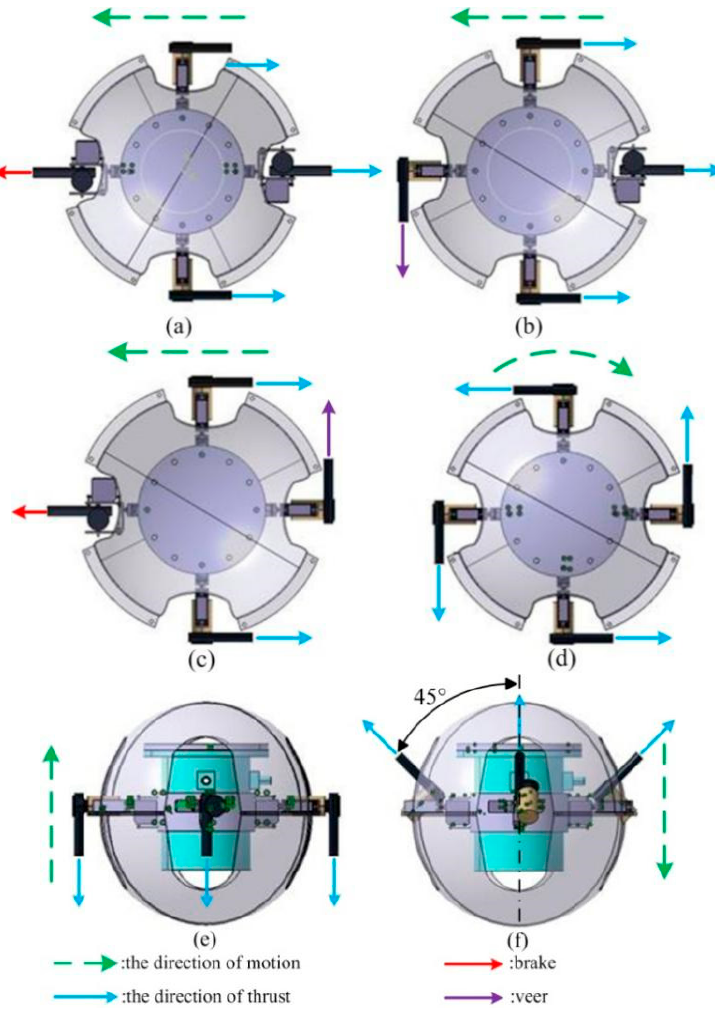
Figure 11. Motion state of SURIII.